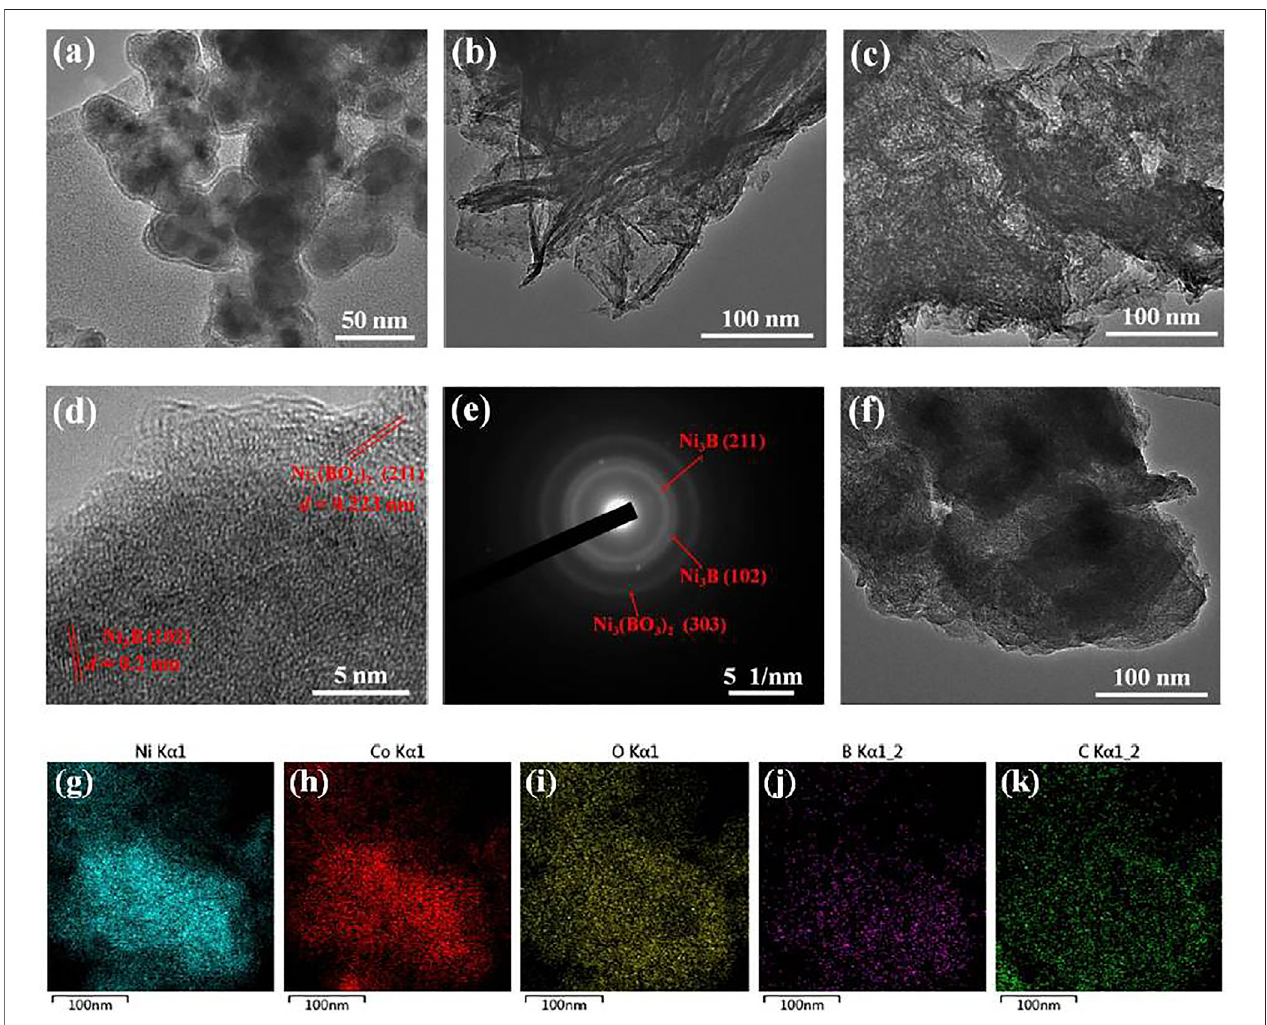
FIGURE2|(A – C) TEMimagesofNBO/RGO,CBO/RGOandNCBO/RGO-3,respectively; (D) HR-TEMimageofNCBO/RGO-3; (E) SAEDimageofNCBO/RGO- 3; (F) TEM image of NCBO/RGO-S that synthesized in STR; (G – I) EDS mapping of different elements in